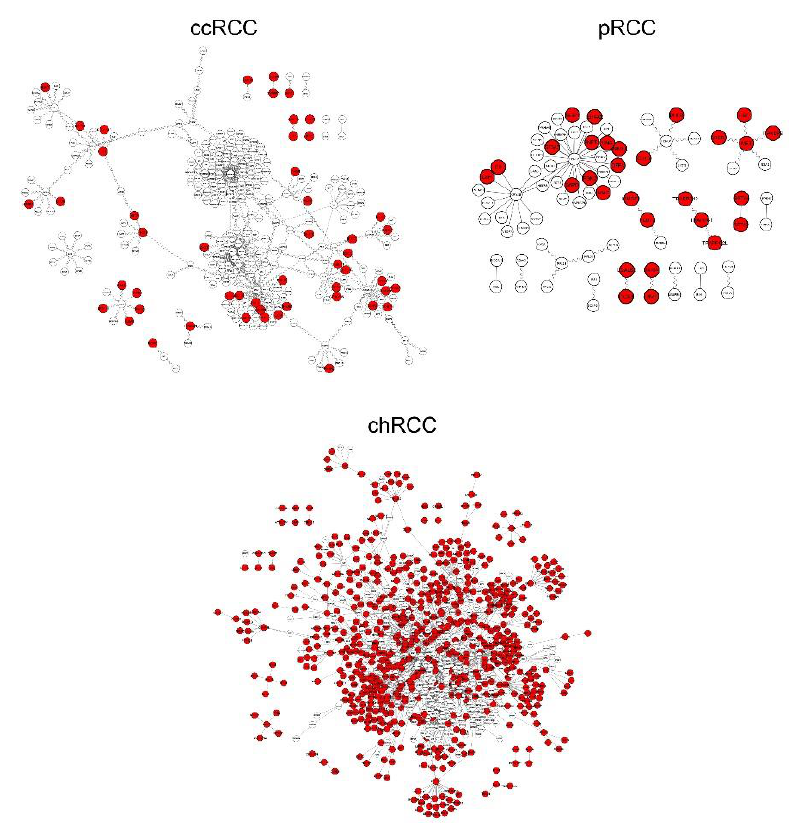
Figure 1. Differential interactome networks reconstructed with differential protein–protein interac- tions (dPPIs) around differentially interacting proteins (DIPs) in three Renal Cell Carcinoma RCC subtypes. Red nodes represent DIPs specific to the subtype of interest. ccRCC: Clear Cell Renal Carcinoma; pRCC: Papillary Renal Cell Carcinoma; chRCC: Chromophobe Renal Cell Carci- noma.